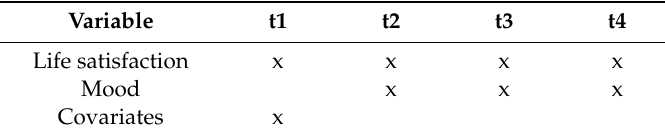
Table 1. Overview of when each variable was